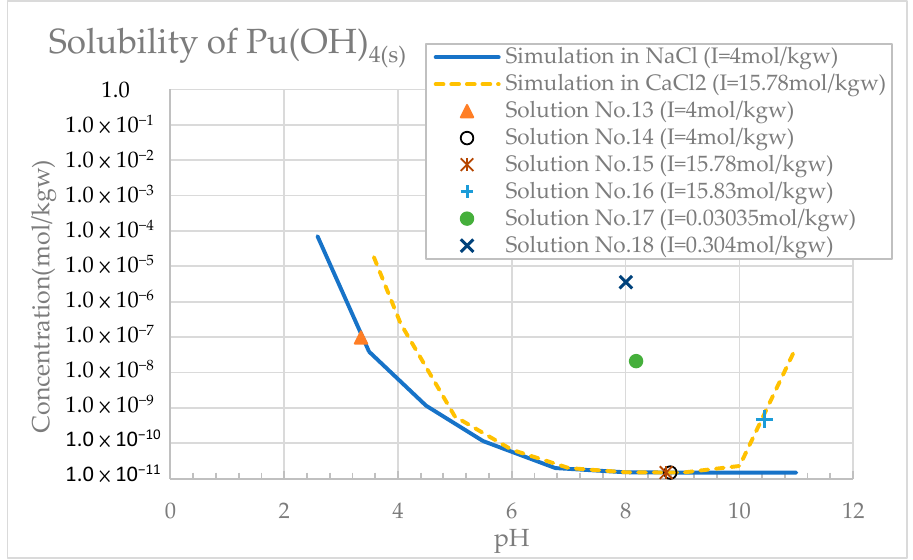
Figure 4. Comparion of the total dissolved concentration of Np(OH) 4(s) in relation to the pH, as cal- culated using the data of solutions No.7, 8, 9, 10, 11 and 12.